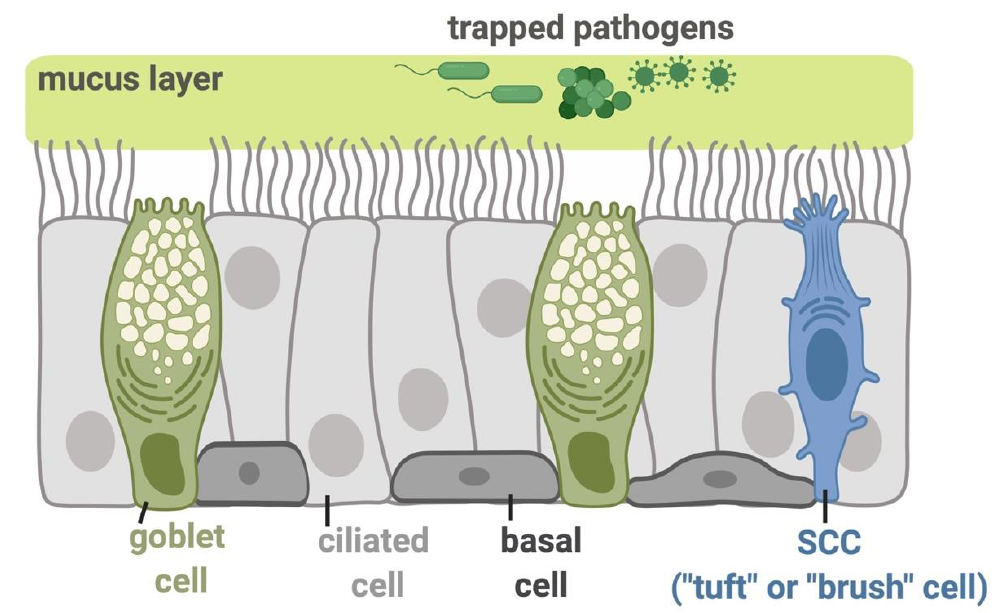
Figure 1. Molecular mechanisms functioning in the airway epithelial innate immunity. The inhaled pathogens, including viruses, bacterial species, and fungi, are trapped in the airway surface liquid (ASL) containing sticky mucus secreted by submucosal exocrine glands and respiratory goblet cells. The trapped pathogens are then eliminated from the airway through mucociliary clearance (MCC), the most important physical defense against these inhaled irritants and microbes. MCC is controlled by the beating of motile cilia and requires the proper regulation of ion and fluid transport by epithelial cells to regulate the mucus viscosity and rheology [5]. The direct killing of pathogens or their inactivation can occur by the secretion of antimicrobial peptides or the production of reactive oxygen species (ROS) and reactive nitrogen species (RNS). The basal cells in the epithelium serve as stem-like cells that can regenerate goblet or ciliated cells during epithelial damage or normal turnover. The ciliated epithelial cells express a gamut of receptors including bitter taste receptors (T2Rs), while solitary chemosensory cells (SCCs; also referred to as tuft or brush cells) express both sweet and bitter taste G protein-coupled receptors (GPCRs), all of which function in regulation of sinonasal innate immunity as described below. All figures were created with BioRender.com.